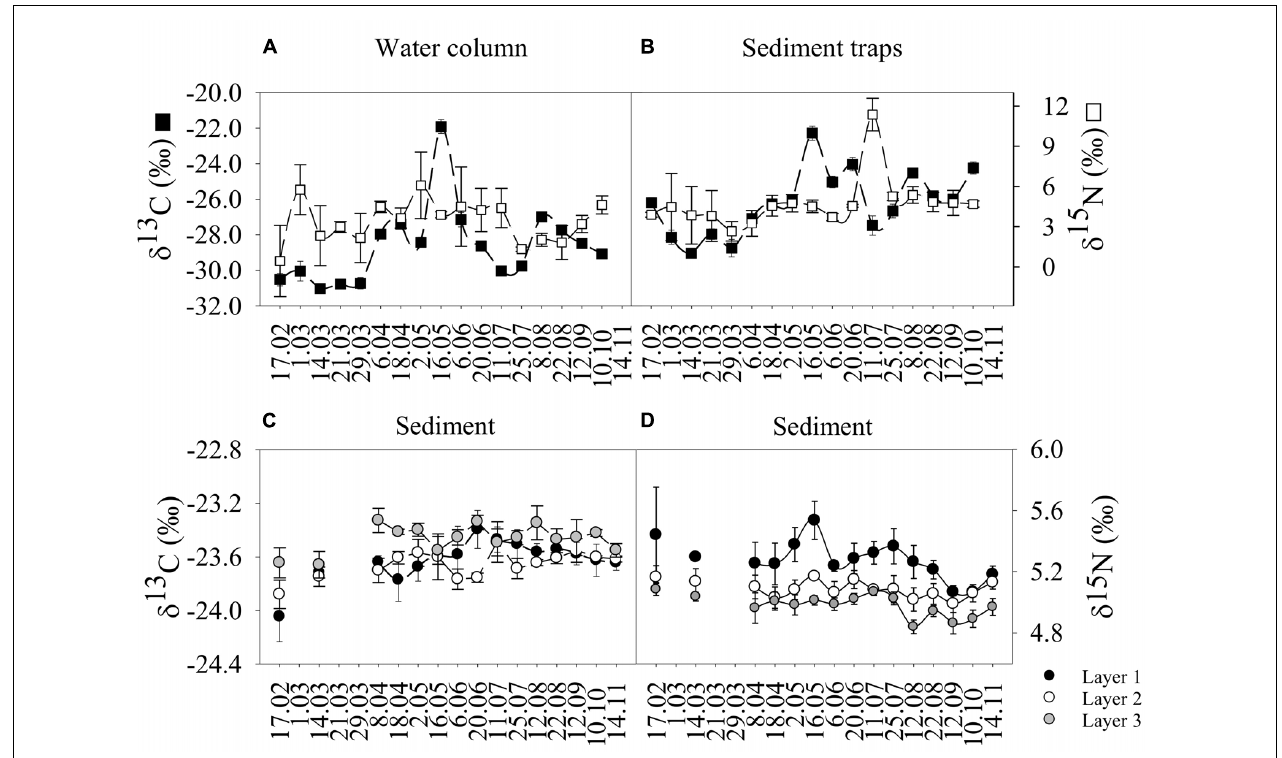
FIGURE 4 | Temporal variation (from February to November 2016) of the δ 13 C and δ 15 N in the water column (A) , sediment traps (B) , and seafloor sediment layers (C,D) . Mean values ± SD are shown. Note that samples for the water column and sediment traps were not taken in November